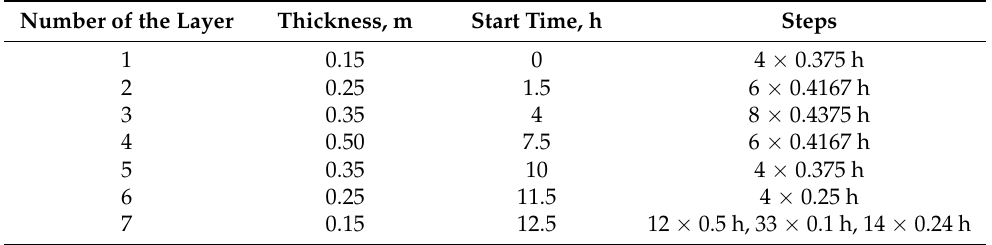
Table 2. Data for the layer projection of continuous casting in the validation of the FE model. Number of the Layer Thickness, m Start Time, h